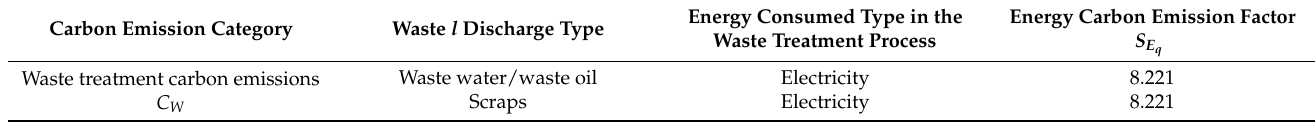
Table 7. Waste disposal carbon emission factor.